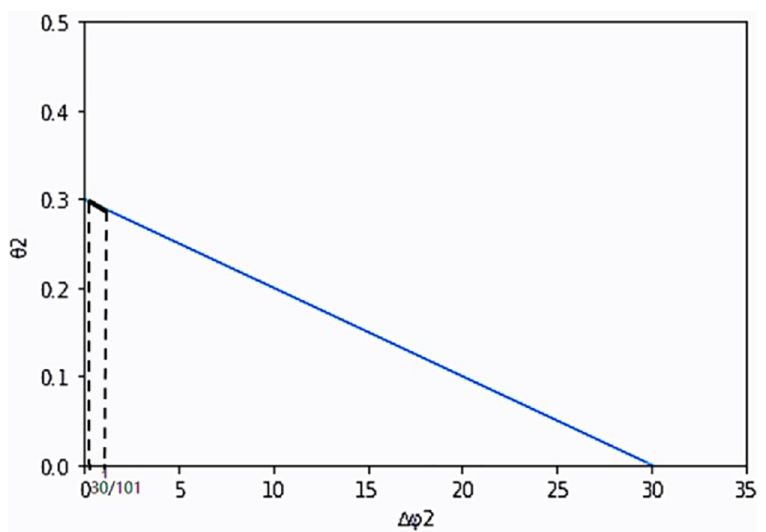
Fig 5. The functional relationship between θ 2 and Δ φ 2 .